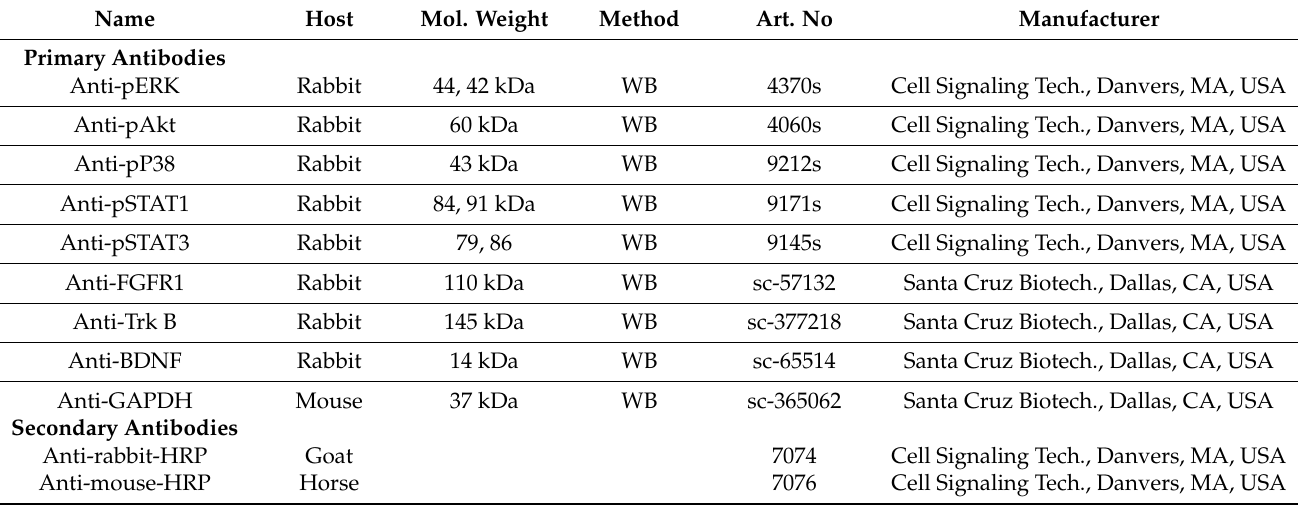
Table 1. List of antibodies used for Western